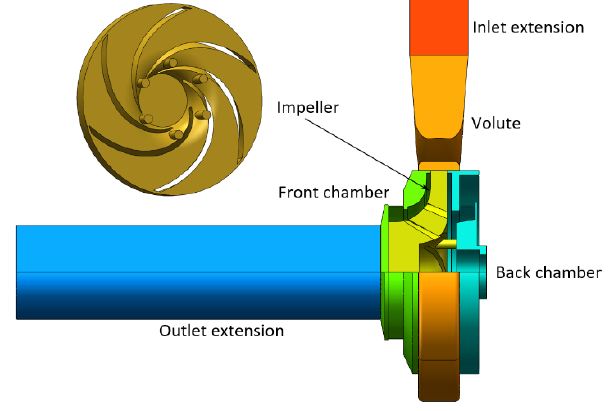
Figure 2. Numerical model of a pump as turbine (PAT).